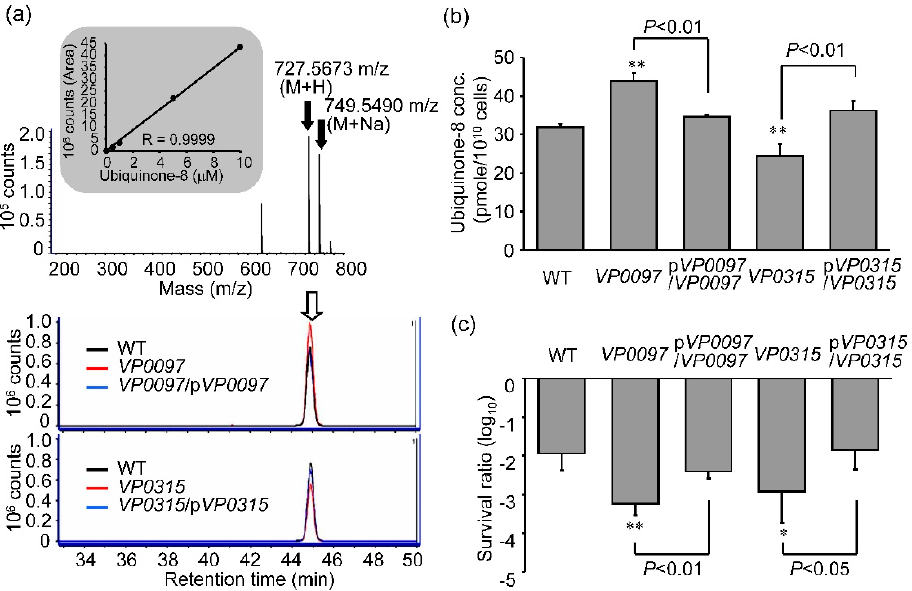
Figure 6. Intracellular ubiquinone-8 concentration and sensitivity to UVA irradiation associated with strains with mutations in ubiquinone biosynthesis genes. ( a ) Mass spectra in the target peak area (white arrow, retention time = 44.8 min) and extracted ion chromatograms (EICs) of ubiquinone-8 (UQ-8, C 51 H 72 O 2 , m/z = 727.5665 [M + H]). Gray panel documents the standard curve featuring UQ-8 purified from Escherichia. Coli . ( b ) Intracellular concentrations of ubiquinone-8. ( c ) Sensitivity to UVA irradiation. Intracellular UQ-8 was measured by liquid chromatography-time of flight mass spectrometry (LC-TOFMS) as described in the materials and methods section. Values shown are means ± SD (n = 3–5, n = number of independent replicates). * p < 0.05 or ** p < 0.01 versus WT.